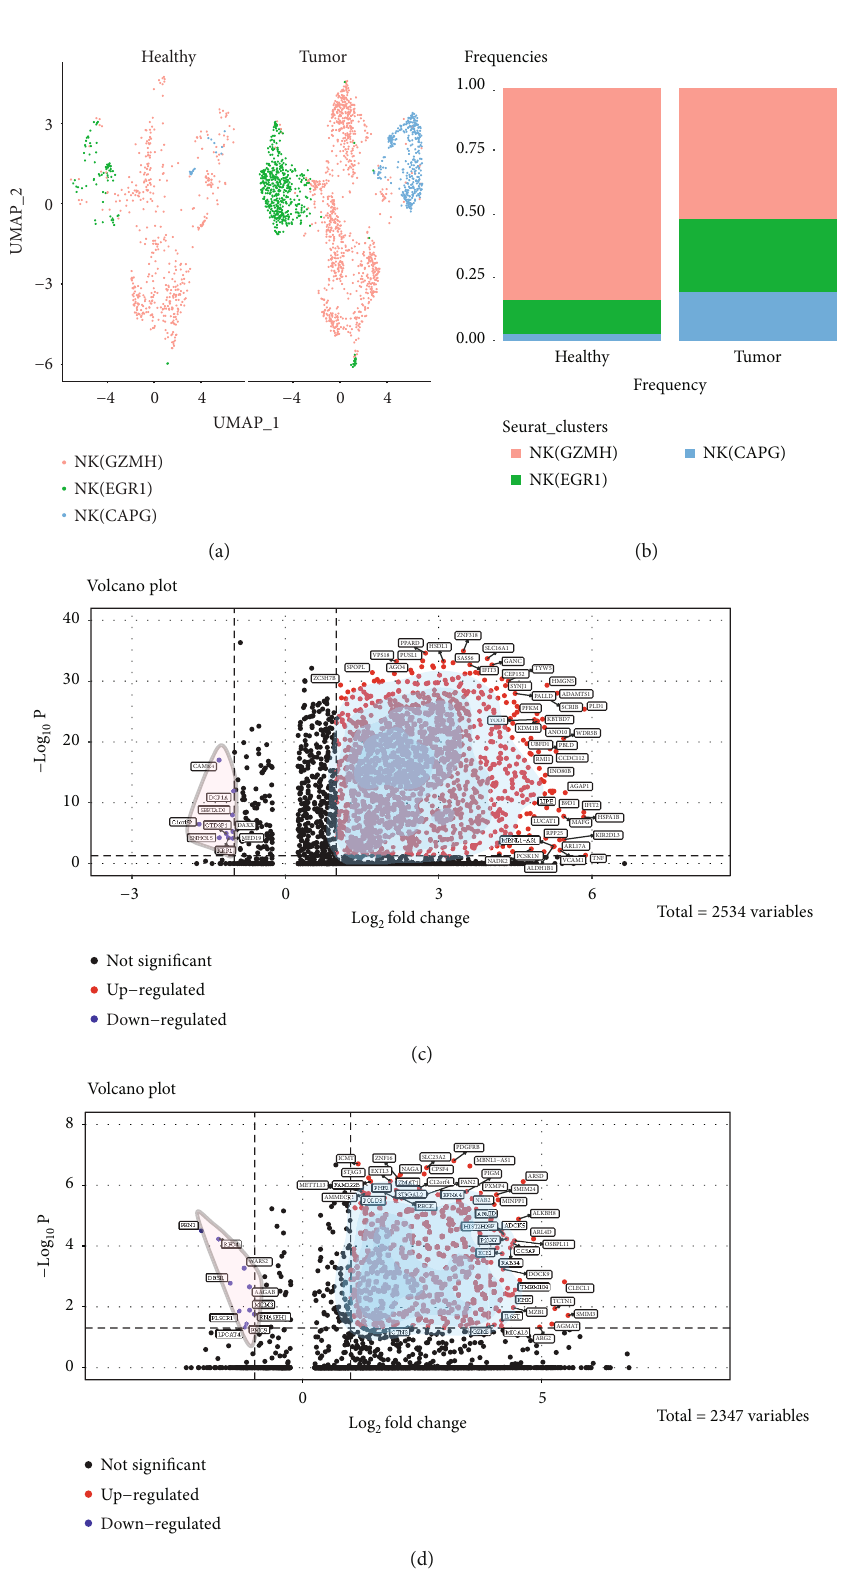
Figure 3: Comparison of natural killer (NK) cell subpopulations between normal kidney and kidney cancer tissues. (a) Split UMAP plots showing the distribution of NK cell subpopulations in normal kidney tissues and clear cell renal cell carcinoma (ccRCC). (b) Stacked bar graph showing the frequency of NK cell subpopulations (normal tissues vs. ccRCC). (c) Volcano plot showing di ff erentially expressed genes (DEGs) in the NK cell subpopulation NK(EGR1) between ccRCC and normal kidney tissues. (d) Volcano plot showing DEGs in the NK cell subpopulation NK(CAPG) between ccRCC and normal kidney